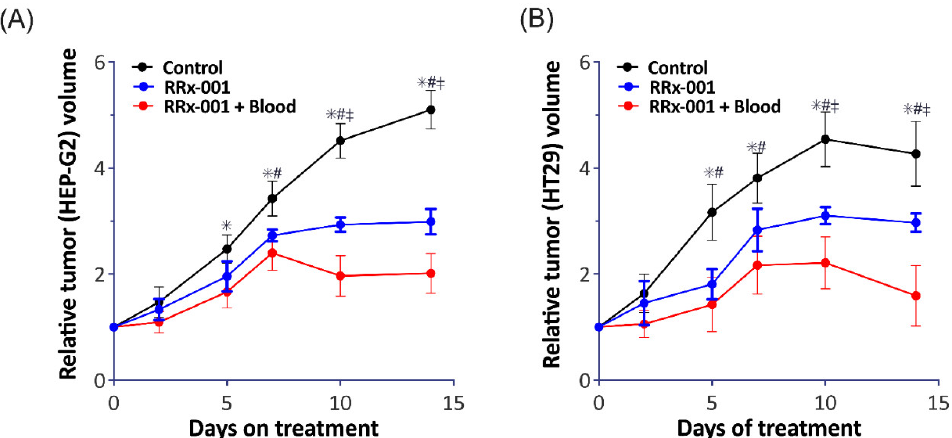
Figure 4. RRx-001 Treated RBCs Augment Tumor Cytotoxicity Compared with RRx-001 treatment alone. Shown here is the relative tumor volume in both our ( A ) HEP-G2 and ( B ) HT29 tumor models after treatment with vehicle (black), RRx-001 alone (blue), and RRx-001 treated RBCs, denoted here as RRx-001 + Blood (red). We observed a significant reduction in both tumor models after treatment with both RRx-001 and RR-001 + blood compared to vehicle control. After 10 days, RRx-001 + blood have an even greater reduction in tumor volume compared with RRx-001 alone. (* p < 0.05 Control vs. RRx-001, # p < 0.05 Control vs. RRx-001 + Blood, ‡ p < 0.05 RRx-001 vs. RRx-001 + Blood).